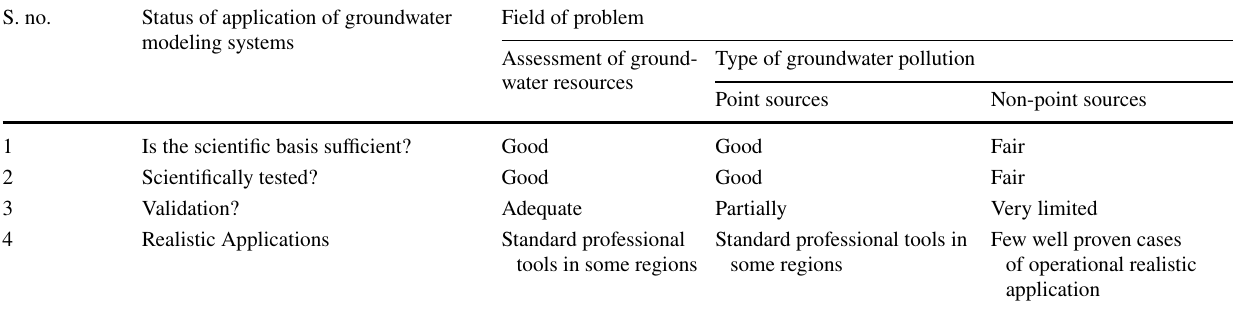
Table 1 Status of hydrological modeling systems (Refsgaard 1996) S.